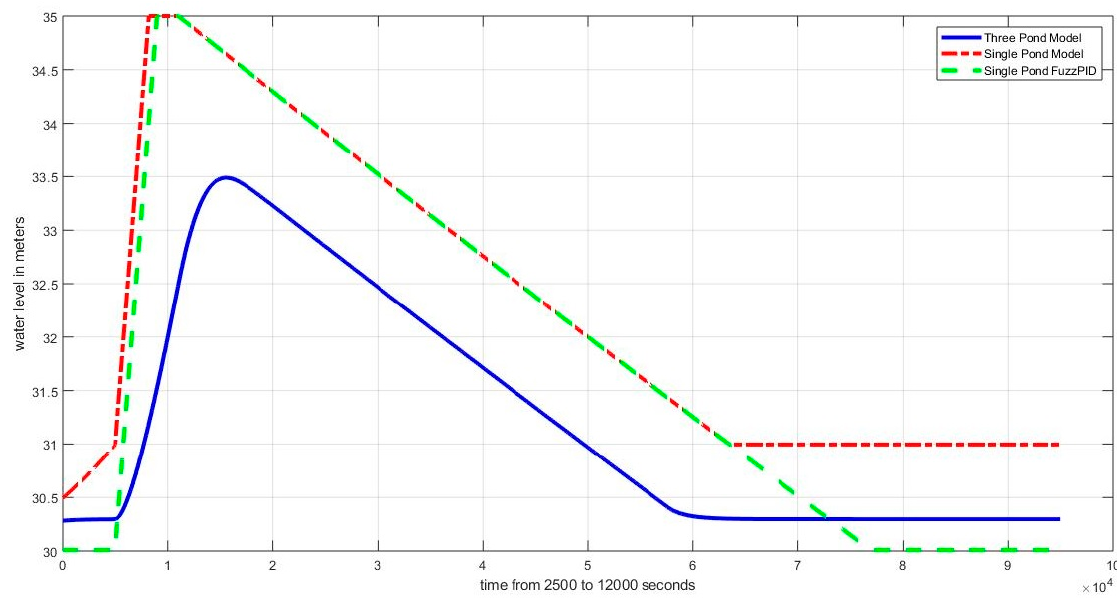
Figure 26. Traditional system (Fuzzy, FuzzyPID) vs. the proposed system (positive surge, steady state).